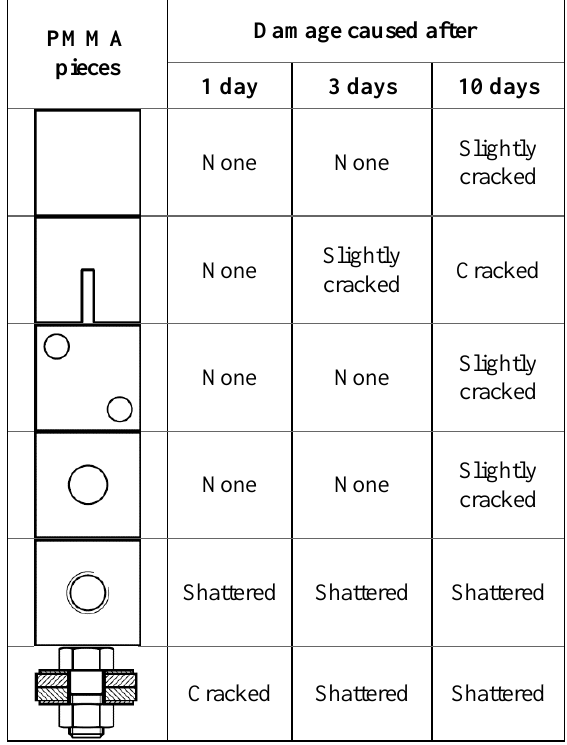
Table 5. Damage caused to perforated PMMA pieces immersed in p-Cymene during 1, 3 and 10